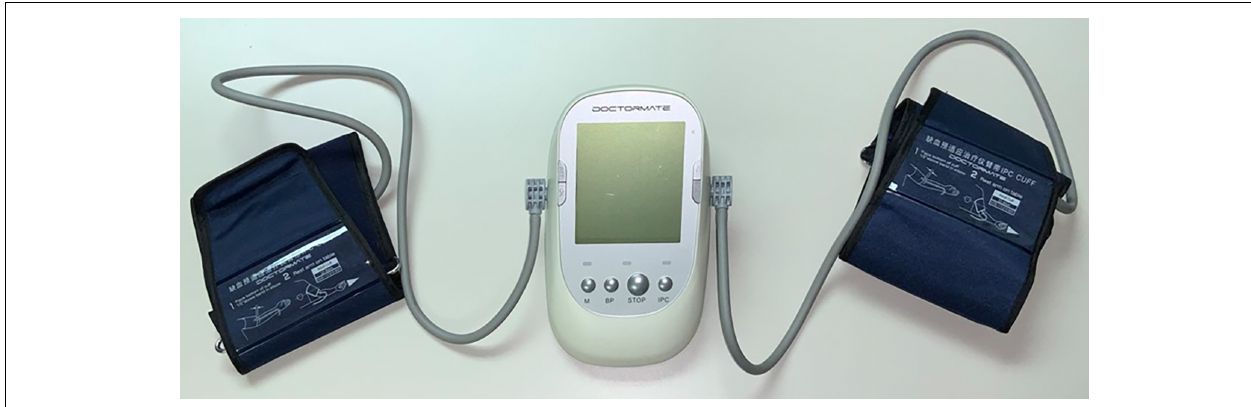
FIGURE 2 | Remote ischemic conditioning (RIC) device. The RIC device is comprised of blood pressure cuffs attached to an automated controller that is programmed to deliver four cycles of 5-min inflation/5-min deflation. The RIC intervention group receives inflation to a cuff pressure of 200 mm Hg. The mock conditioned group receives cuff placement, but without inflation. The cuff is placed on the upper arm by trained medical